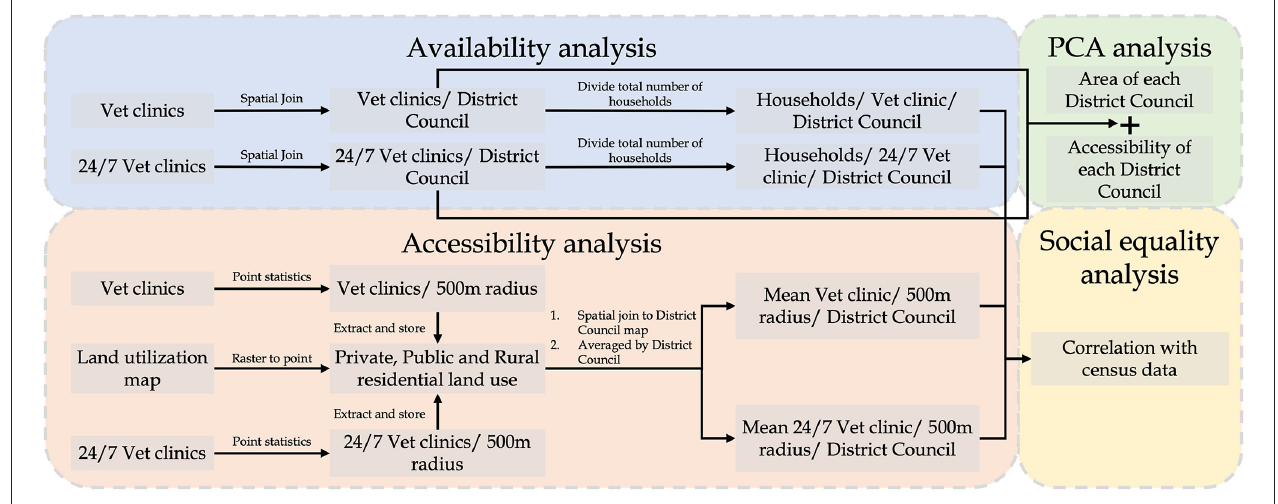
FIGURE 2 | Flow chart of the data processing and analysis of this